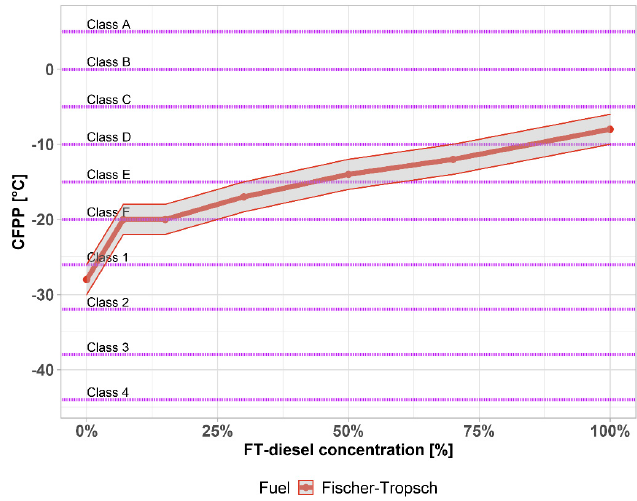
Figure 5. Cold filter plug point of FT − diesel mixtures.